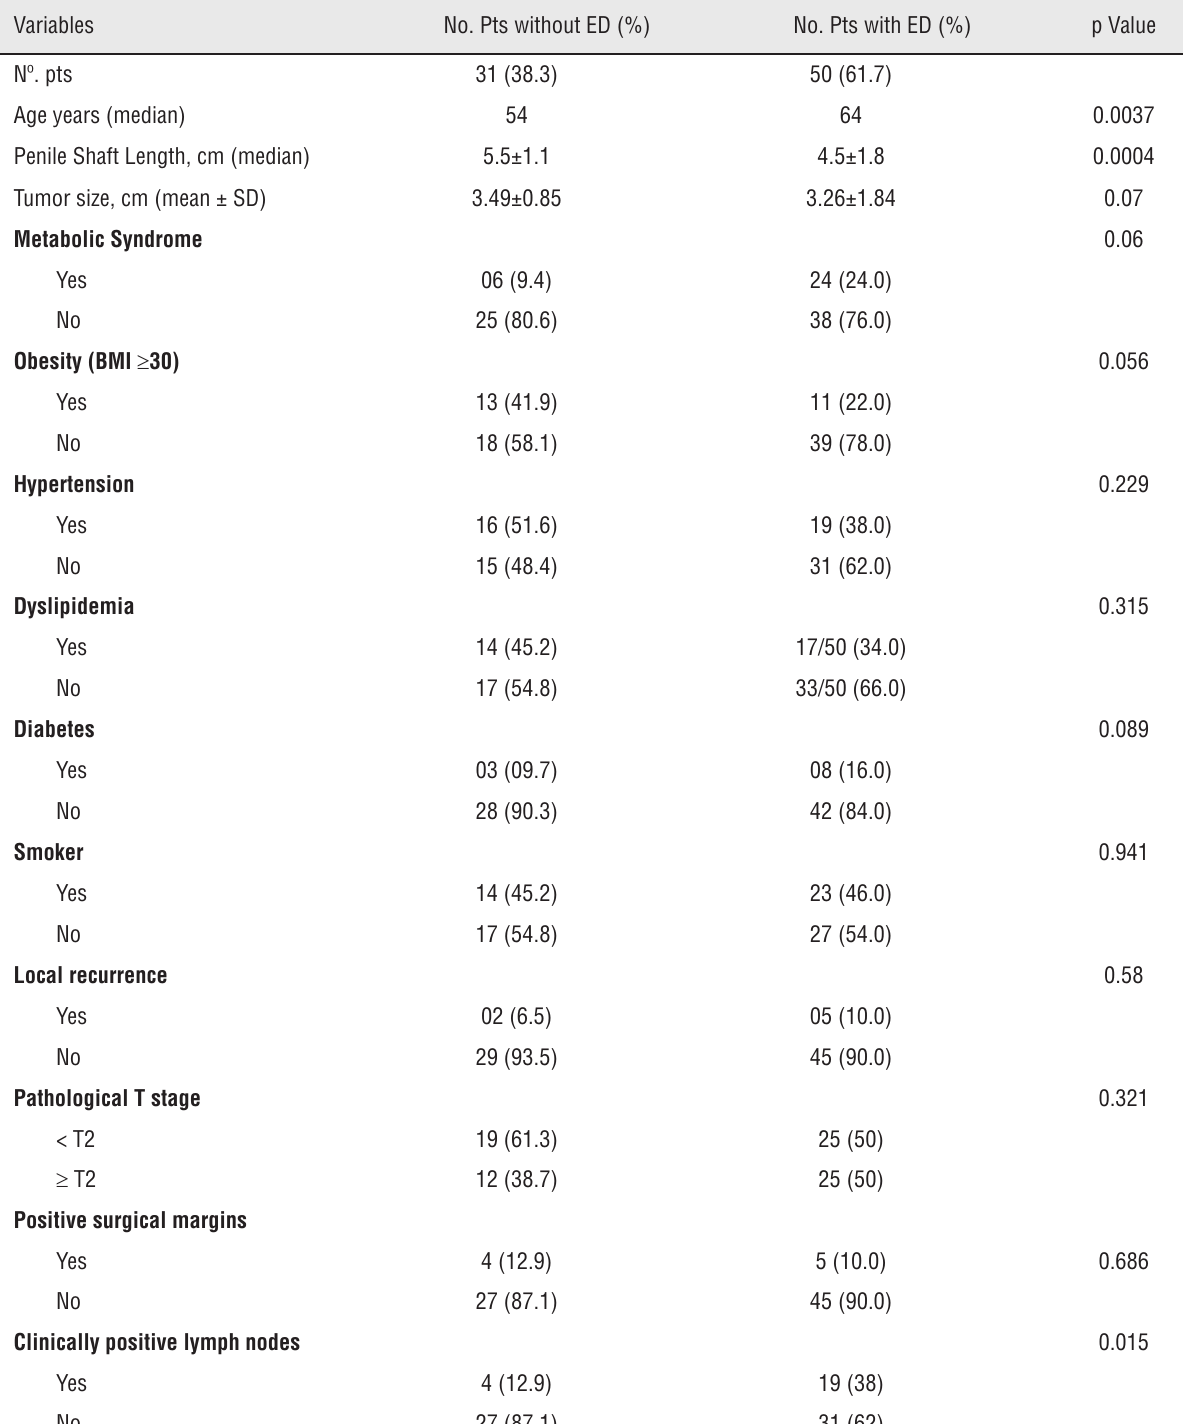
Table 2 - Clinical and pathological differences between patients without and with